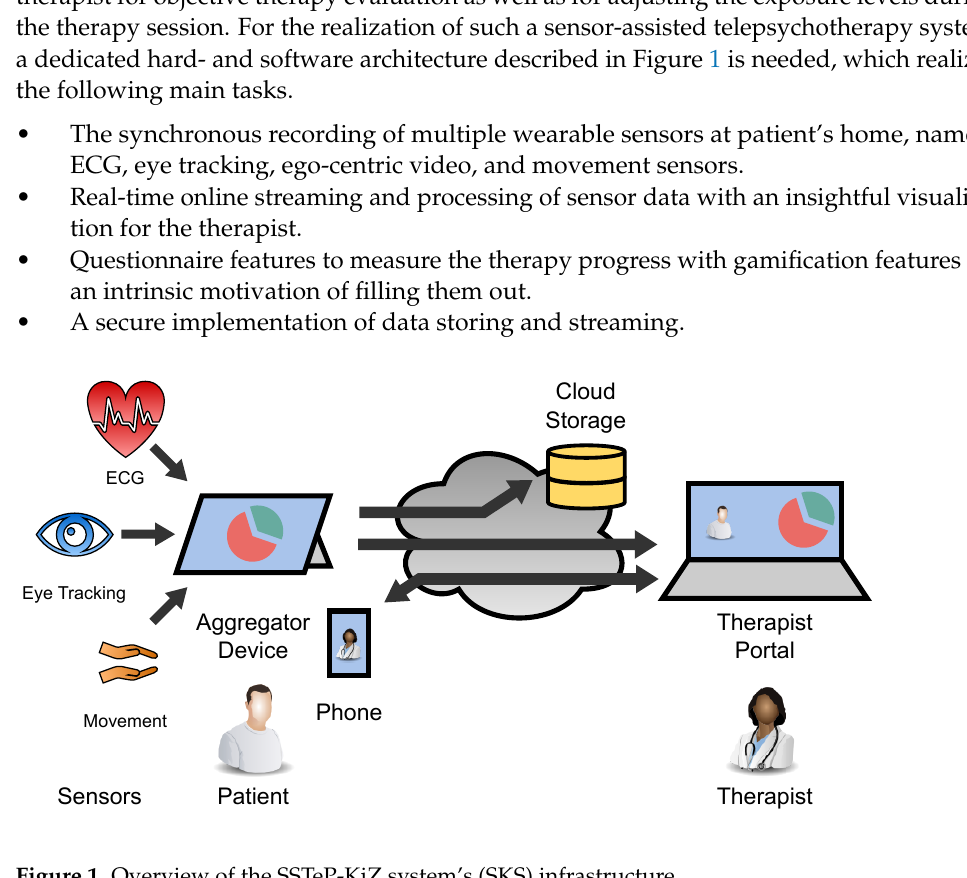
Figure 1. Overview of the SSTeP-KiZ system’s (SKS)